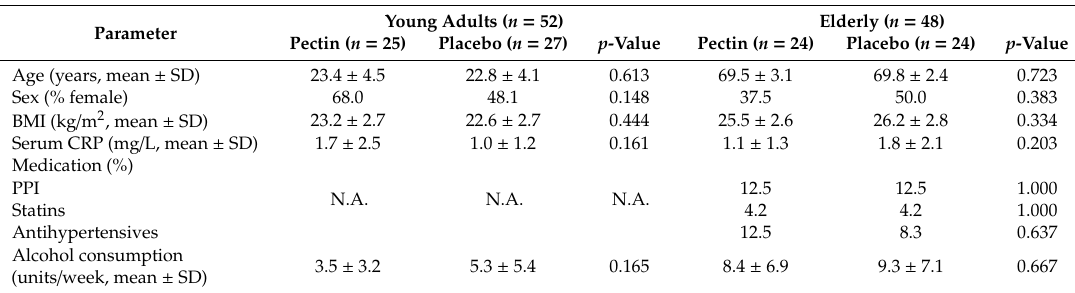
Figure 2. Flow diagram of the study. Table 1. Baseline characteristics of the total sample of young adults ( n = 52) and elderly ( n = 48), undergoing either placebo or pectin